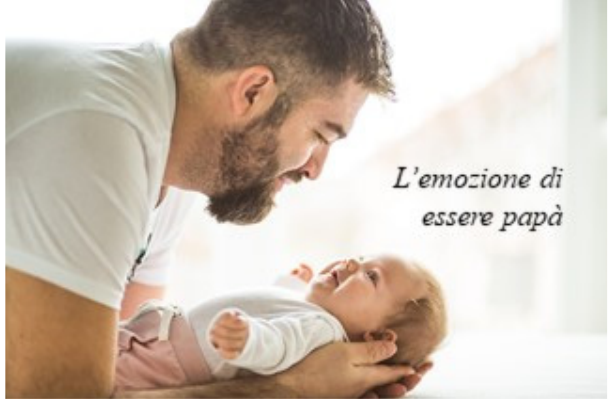
Figure 5. Elena’s choice of photograph and title “The emotion of being a father”. Reproduced with permission from www.istockphoto.com (accessed on 3 June 2021).